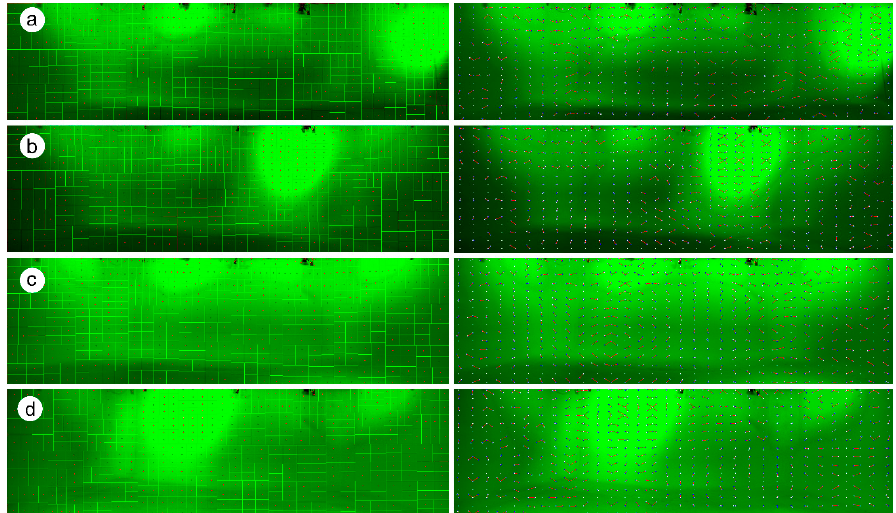
Figure 11. Images of the four tests performed: right spot light ( a ), center right spot light ( b ), center light ( c ) and left light ( d ). The images represent the 512 regions subdivision ( left ) and the centroid correspondence ( right ).